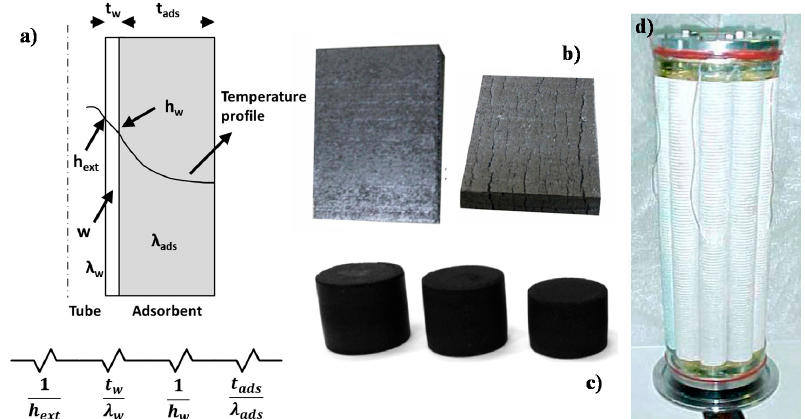
Figure 4. Images of the consolidated bed configurations: ( a ) schematics of thermal resistance in a solid adsorbent bed. ( b ) Comparison between samples: embrittlement and fracture effect of consolidated bed due to the increase in activated carbon content [43]. ( c ) Consolidated composite adsorbents of a highly porous activated carbon powder, expanded graphite (EG) and a binder [38]. ( d ) Finned-tube heat exchanger with the external surface coated by a consolidated layer of SWS-1L with a salt content of 33.7 and 25 wt.% of bentonite clay as a binder [28]. (Copyright from Elsevier